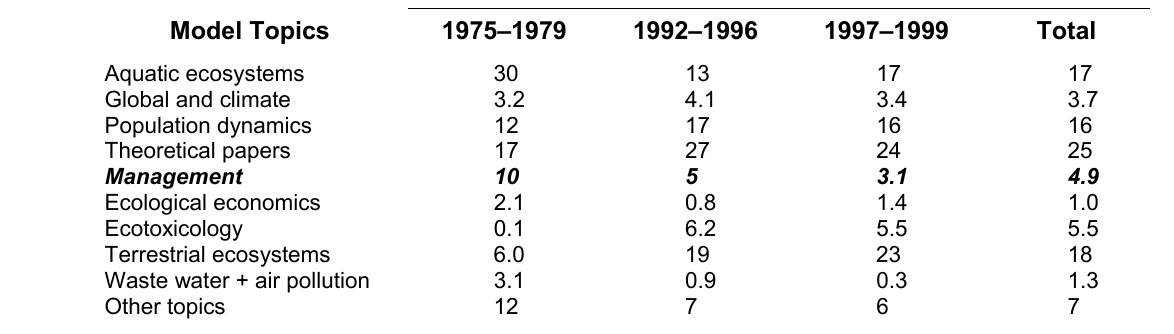
Development in Model